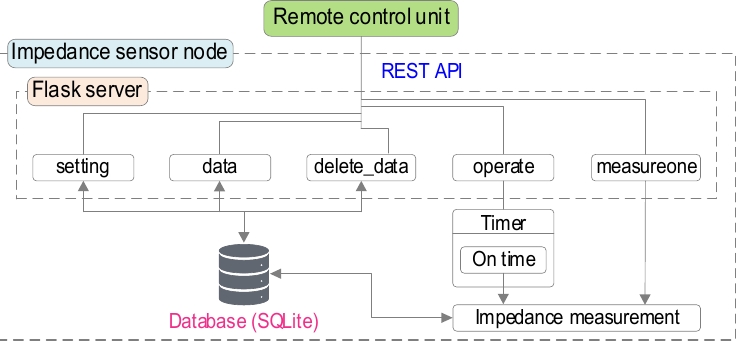
Figure 8. Control scheme of impedance monitoring system ‘ SSeL-Pi ’ .